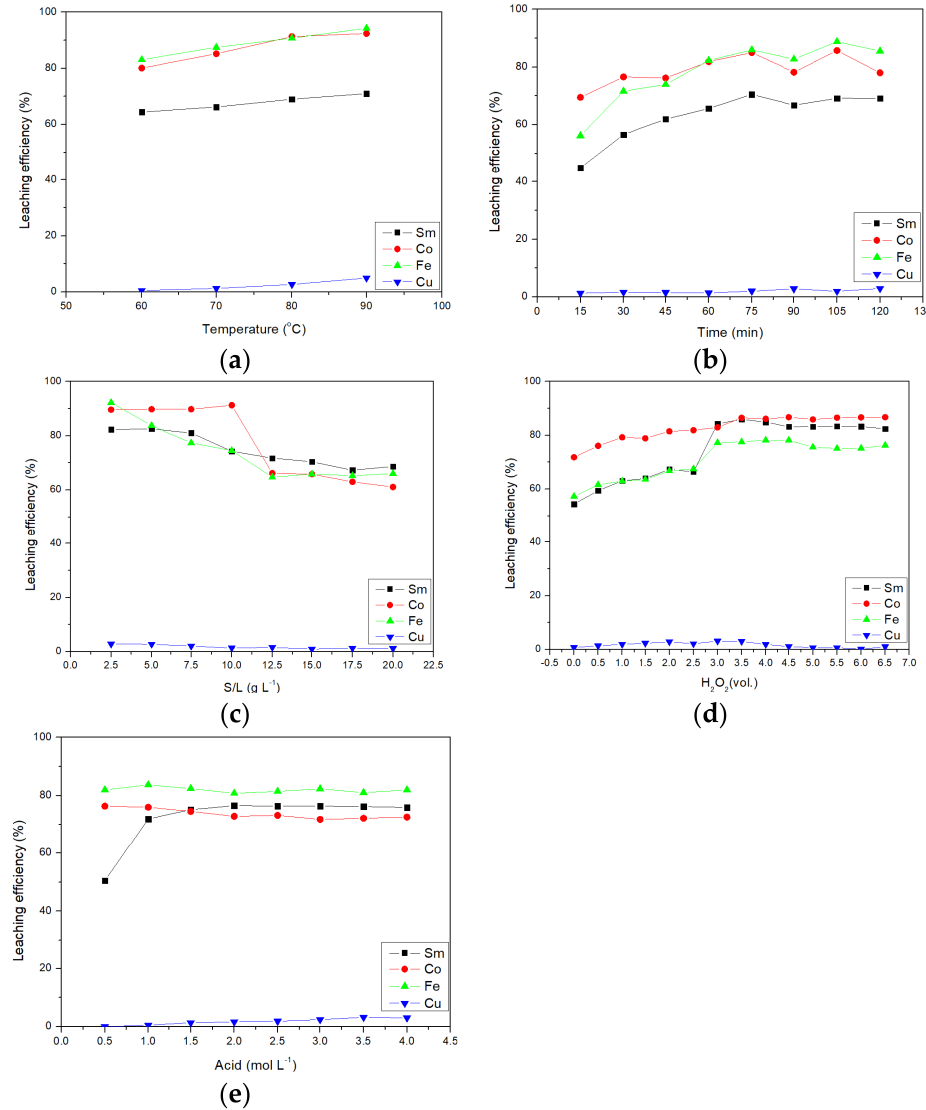
Figure 3. Effect of ( a ) temperature, ( b ) time, ( c ) S/L ratio, ( d ) amount of H 2 O 2 , and ( e ) acid concen- tration on leaching efficiency of malic